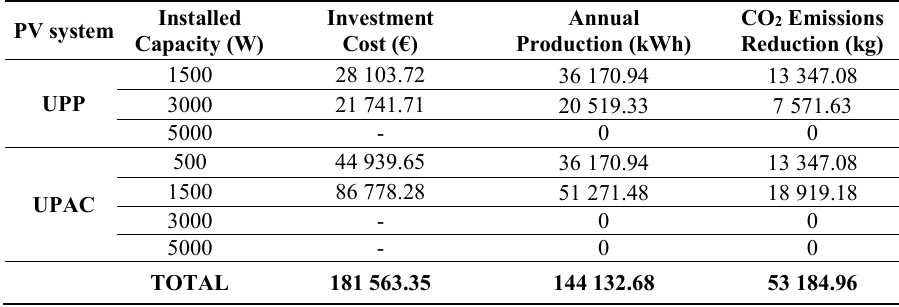
Table 3. E3 Impacts - Conservative Scenario.